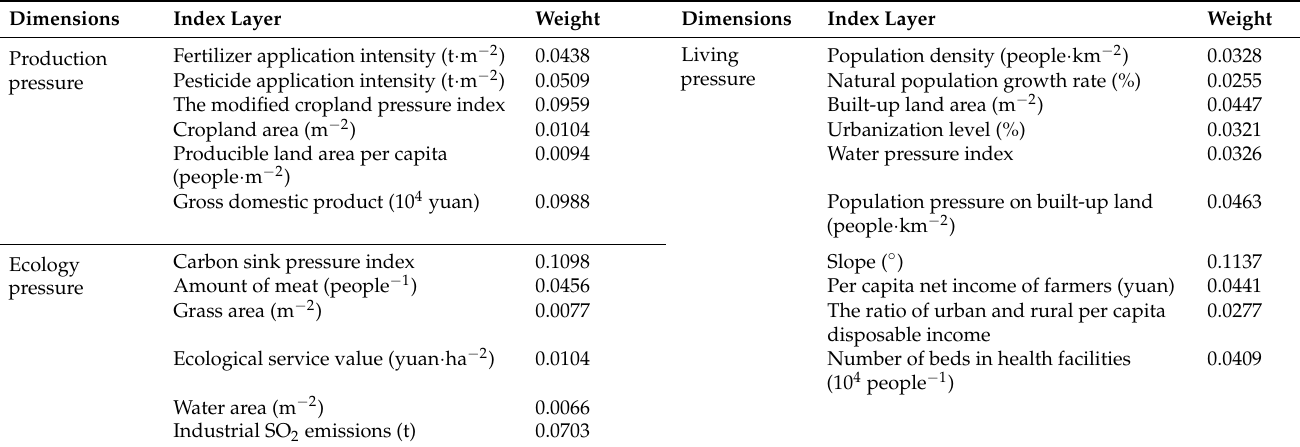
Table A1. Land pressure score evaluation index